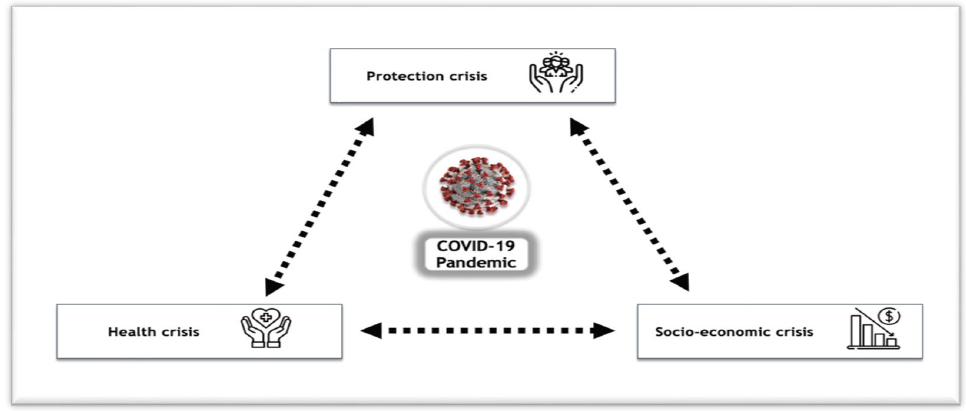
Figure 1. Social vulnerability: a conceptual framework to interpret the impact of the COVID-19 pan- demic and subsequent lockdown on migrants (adapted from UN Sustainable Development Group) (Reprinted/adapted with permission from Ref. [15]. Copyright 2021, UN Sustainable Development Group).